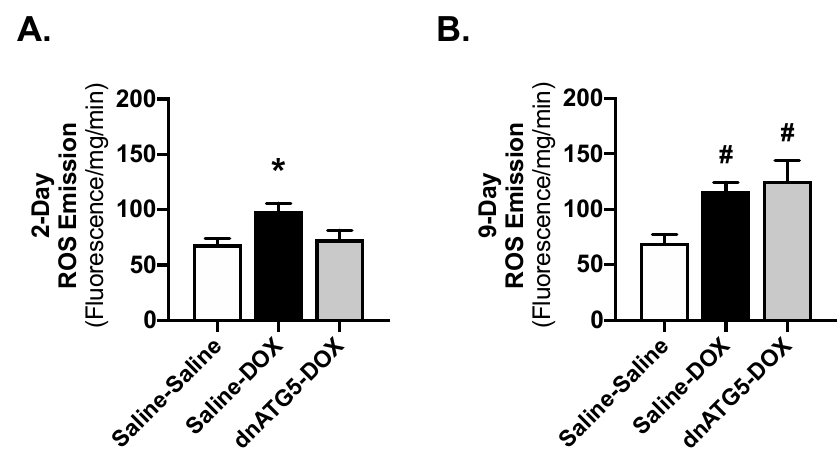
Figure 4. Reactive oxygen species (ROS) emission. H 2 O 2 emission from permeabilized cardiac muscle fibers at the ( A ) 2-day and ( B ) 9-day timepoints. Values are presented as means ± SEM, n = 7–9 / group. * significantly different versus all groups ( p < 0.05). # significantly different versus Saline-Saline ( p < 0.05). Table 3. Cardiac muscle mitochondria state 3 respiration, state 4 respiration and respiratory control ratio (RCR).